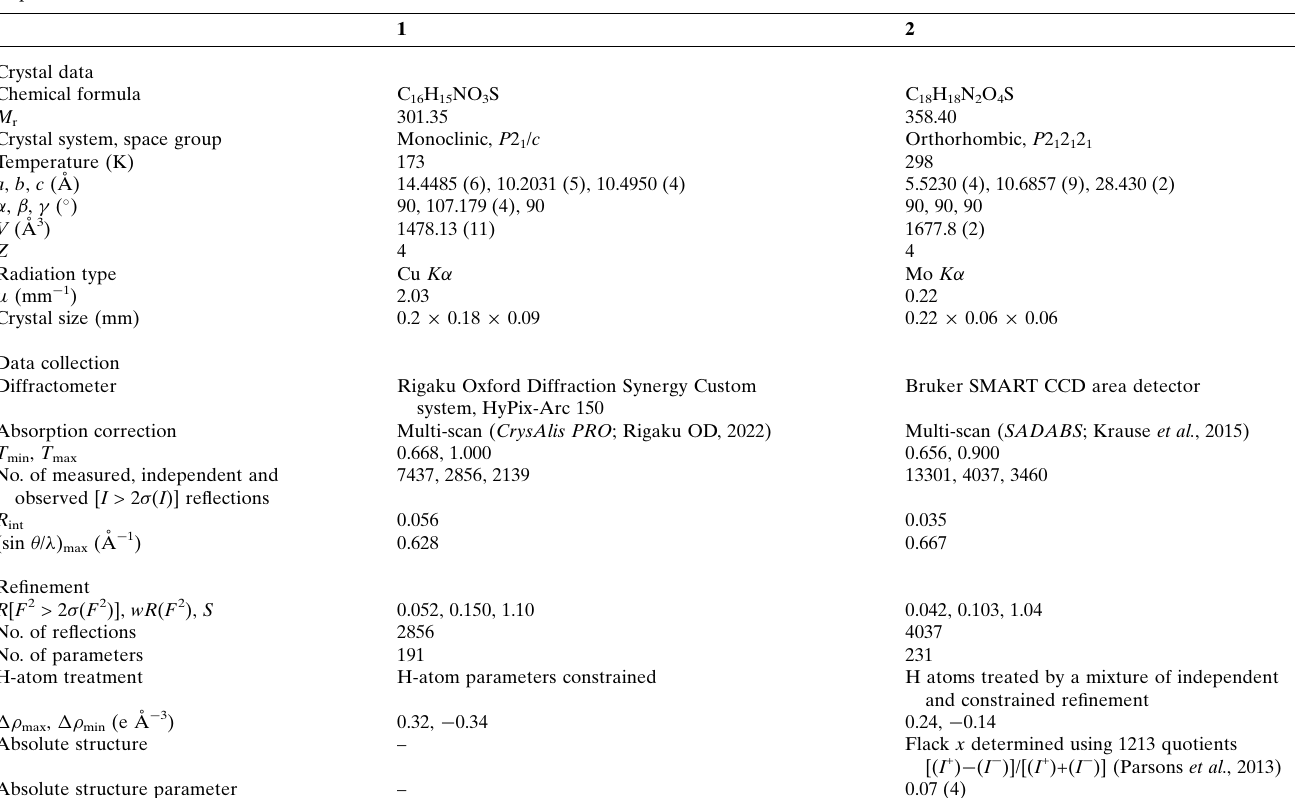
Table 3 Experimental details.